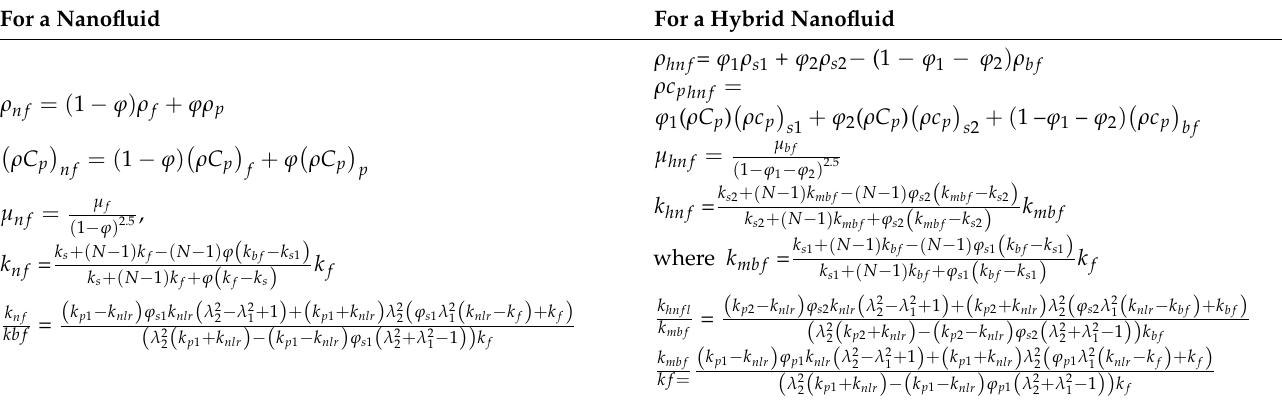
Table 2. Thermophysical properties of a hybrid nanofluid proposed in [42,43]. For a Nanofluid For a Hybrid